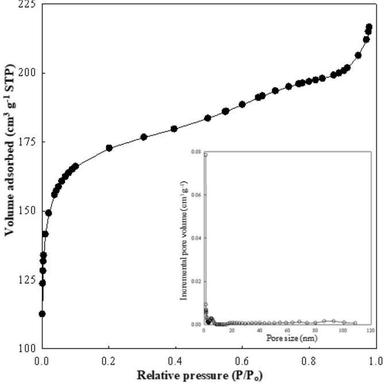
Nitrogen sorption isotherm and pore size distribution curve (inset) of FLPWAC composite.